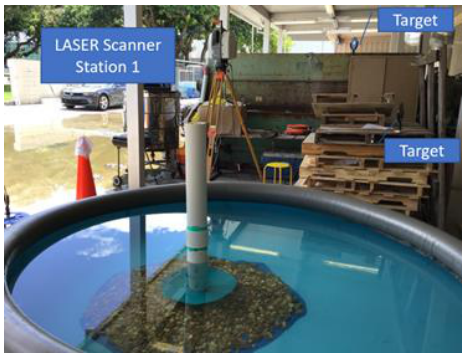
Figure 6. Scan station one in operation [35,36] (used with permission).